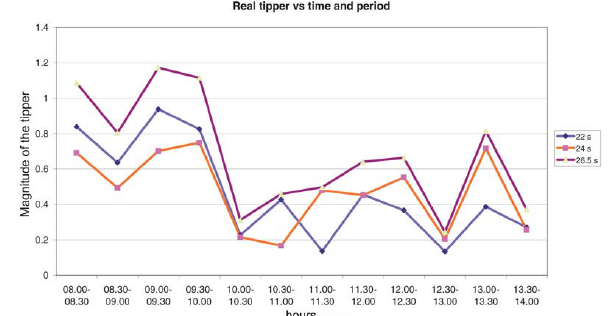
Fig. 9. BBZ real tippers vs. period in 2-hour sections (FLR periods, 22-32 s).